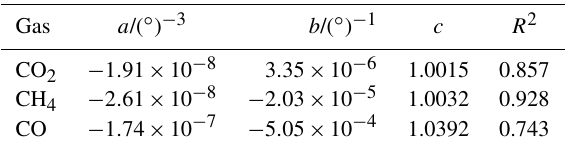
Table 2. Parameters a , b , and c (and coefficients of determination R 2 ) used for correcting the spurious SZA dependency of the mea-